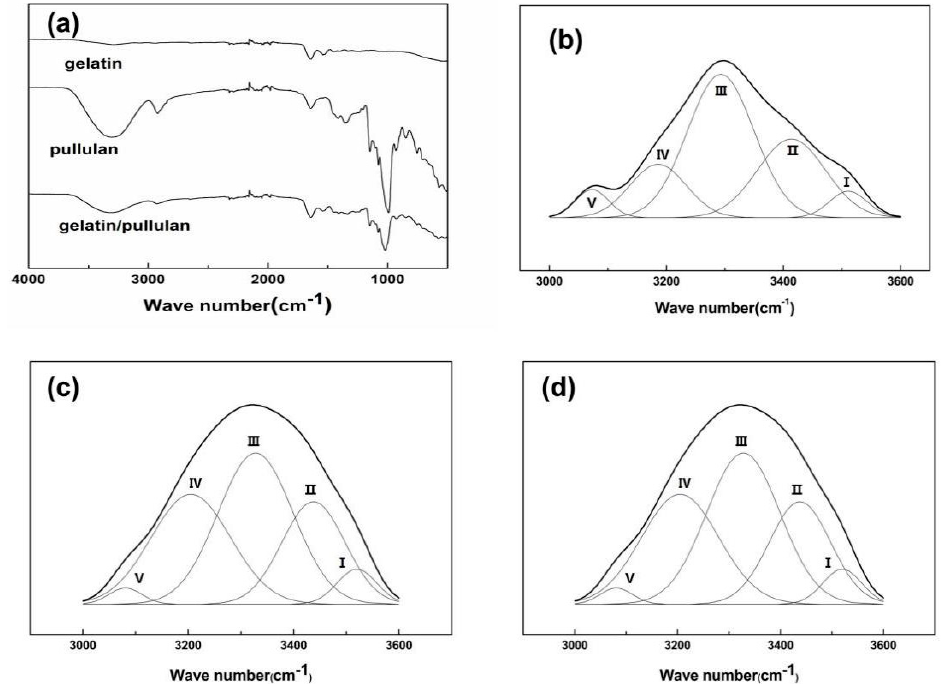
Figure 6. Spectra of pullulan, gelatin, and gelatin / pullulan blend ( a ), and Gauss curve fitting by hydrogen bonds of composite materials: ( b ) gelatin; ( c ) pullulan, and ( d ) gelatin / pullulan blend. Table 1. The fitting results of various kinds of hydrogen bonds.